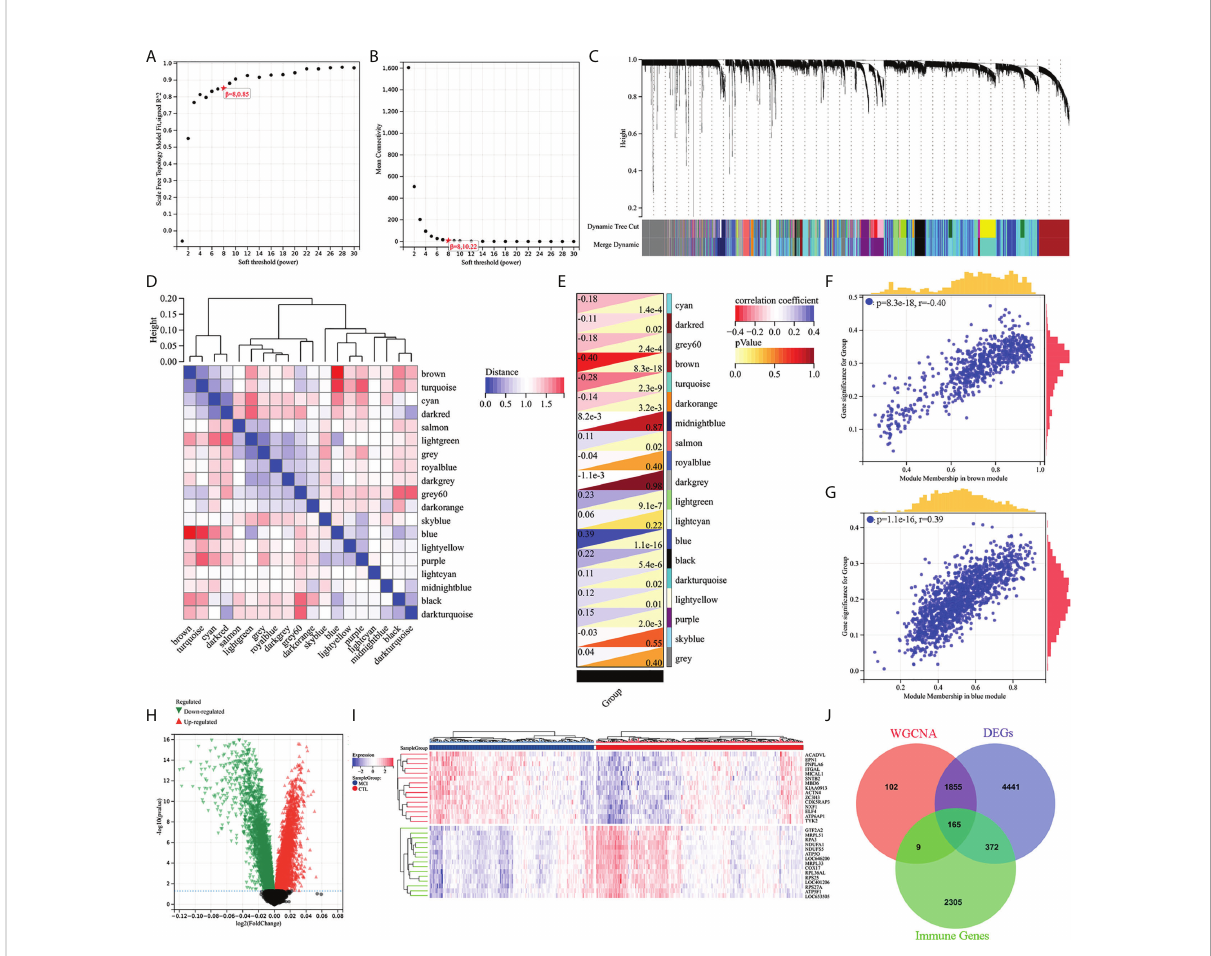
FIGURE 2 Screening of immune-related different expression genes (IRDEGs). (A) Analysis of the scale-free index for various soft-threshold powers ( b ). (B) Analysis of the mean connectivity for various soft-threshold powers. (C) Recognition module, each module was given an individual color as an identi fi er, including 19 different modules. (D) Coexpression similarity of entire modules based on hierarchical clustering of module eigengenes and correlation between different modules; red indicates high adjacency (positive correlation), and blue indicates low adjacency (negative correlation). (E – G) Correlation heat map of gene modules and phenotypes, with blue being positively correlated with the phenotype and red being negatively correlated. (H) Volcanic map of differential expression genes between the HC and MCI groups. p -value < 0.05 and | log2 Fold change| > 0. (I) The heat map shows the top 15 differentially expressed genes that are most signi fi cantly up- or downregulated. (J) The Venn diagram represents the common intersection of WGCNA, differentially expressed genes, and immunity genes from the InnateDB and ImmPort